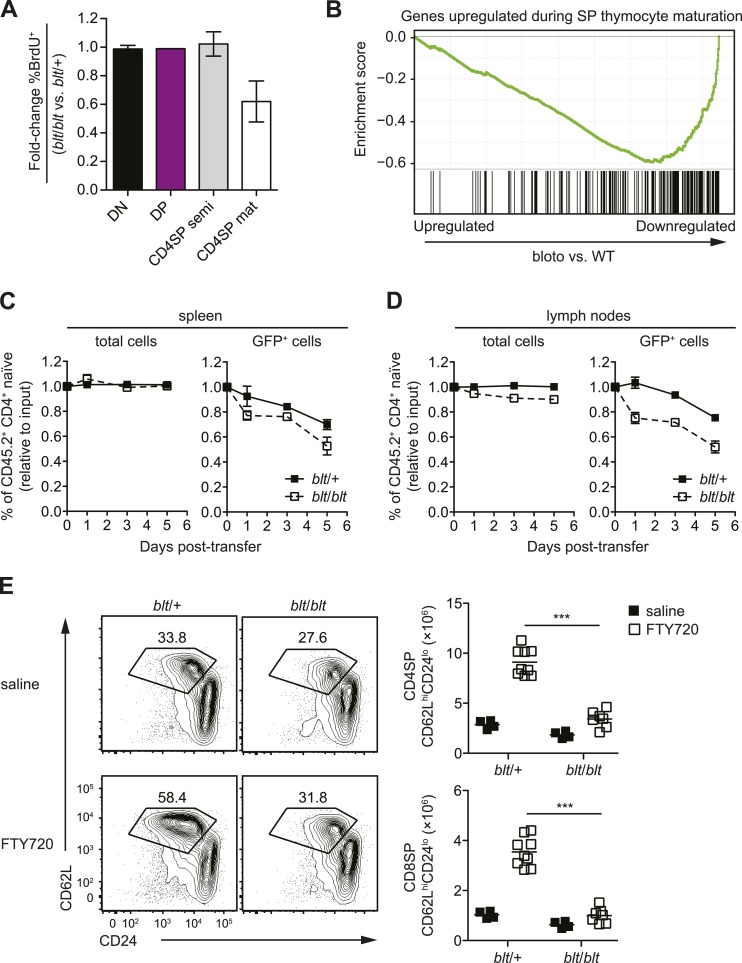
Zfp335R1092W-induced T cell dysregulation affects mainly
mature SP thymocytes and recent thymic emigrants.(A) Percentage of BrdU+ cells in indicated
thymocyte populations from blt/blt mice relative to
blt/+ controls after 4 days of continuous BrdU
labeling (mean ± s.d., n = 4). (B) Gene set
enrichment analysis (GSEA) analysis of gene expression data from
blt/blt vs WT mature CD4SP thymocytes showing
significant negative correlation with genes known to be upregulated
during SP thymocyte maturation (MSigDB gene set: GSE30083).
(C and D) Input-normalized fraction of total
(left panel) or GFP+ (right panel) Rag1-GFP
blt/+ and Rag1-GFP
blt/blt cells within the total
CD45.2+ CD4+ naïve donor population recovered
from recipient spleens (C) and peripheral lymph nodes
(D) at indicated time points after co–transfer with
control CD45.2+
blt/+ cells. (E) Flow cytometry analysis of
CD4SP cells in the thymus of blt/blt
mice and blt/+ controls after 4 days of FTY720 or saline
treatment. Percentage of cells in mature SP
(CD62LhiCD24lo) gate shown. Results are
quantified (right) for CD4SP and CD8SP thymocytes. ***p < 0.001
(two-tailed Mann–Whitney test), data pooled from four independent
experiments.